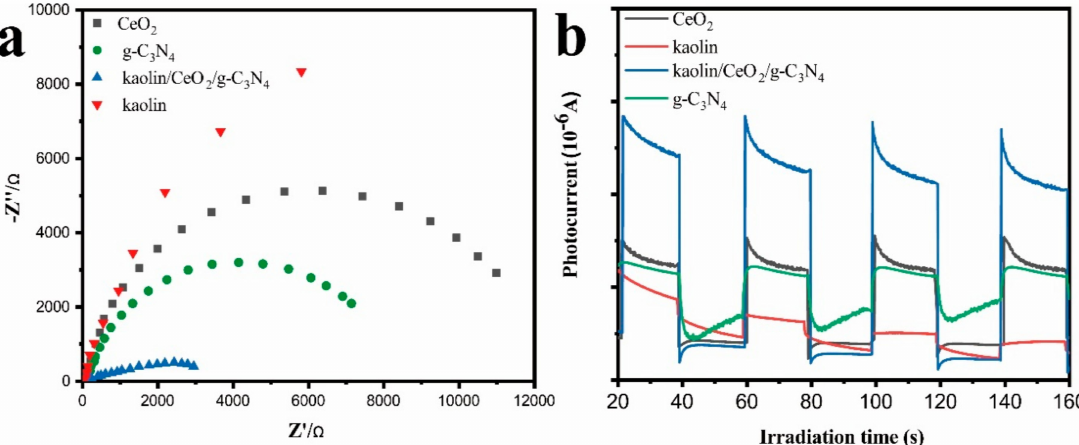
Figure 8. Transient photocurrent and Nyquist plots from electrochemical impedance spectroscopy (EIS) data for the composite and reference samples. ( a ) Nyquist plots for kaolin, CeO 2 , g-C 3 N 4 and kaolin / CeO 2 / g-C 3 N 4 composite, ( b ) transient photocurrent produced in kaolin, CeO 2 , g-C 3 N 4 and kaolin / CeO 2 / g-C 3 N 4